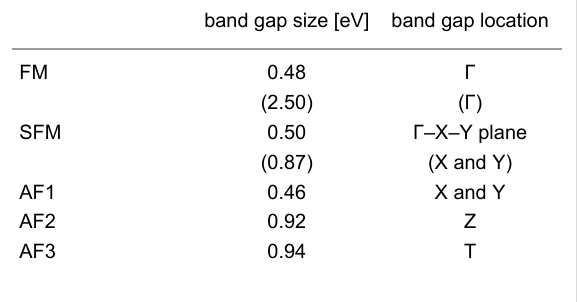
Table 4: Band structure features: the band gap size and the location of the direct band gap. Values for the minority spin component are given in brackets if they differ from the value for the majority spin